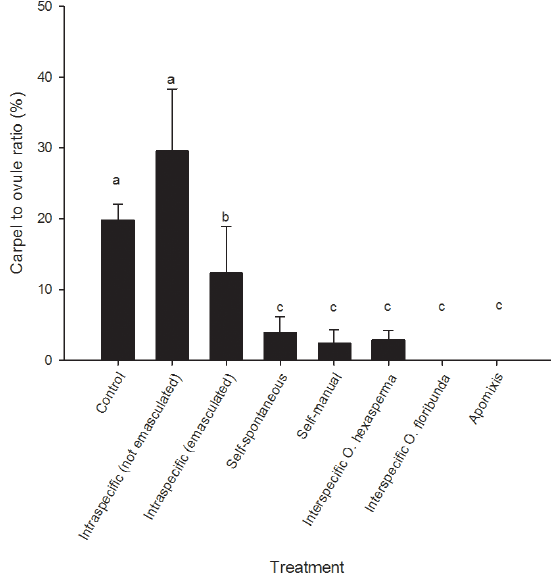
Figure 1. Carpel-to-ovule ratio for each of the treatments in O. spectabilis flowers, calculated as the % of the ratio between the number of mature carpels developed per total number of ovules available. Mean ± SE is shown. Different letters indicate statisti- cally significant differences ( p ≤ 0 .